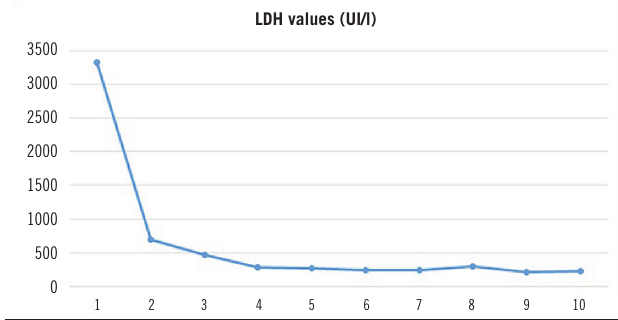
figurE 5 − Variation of LDH values (UI/l) during hospital stay LDH: lactate dehydrogenase.